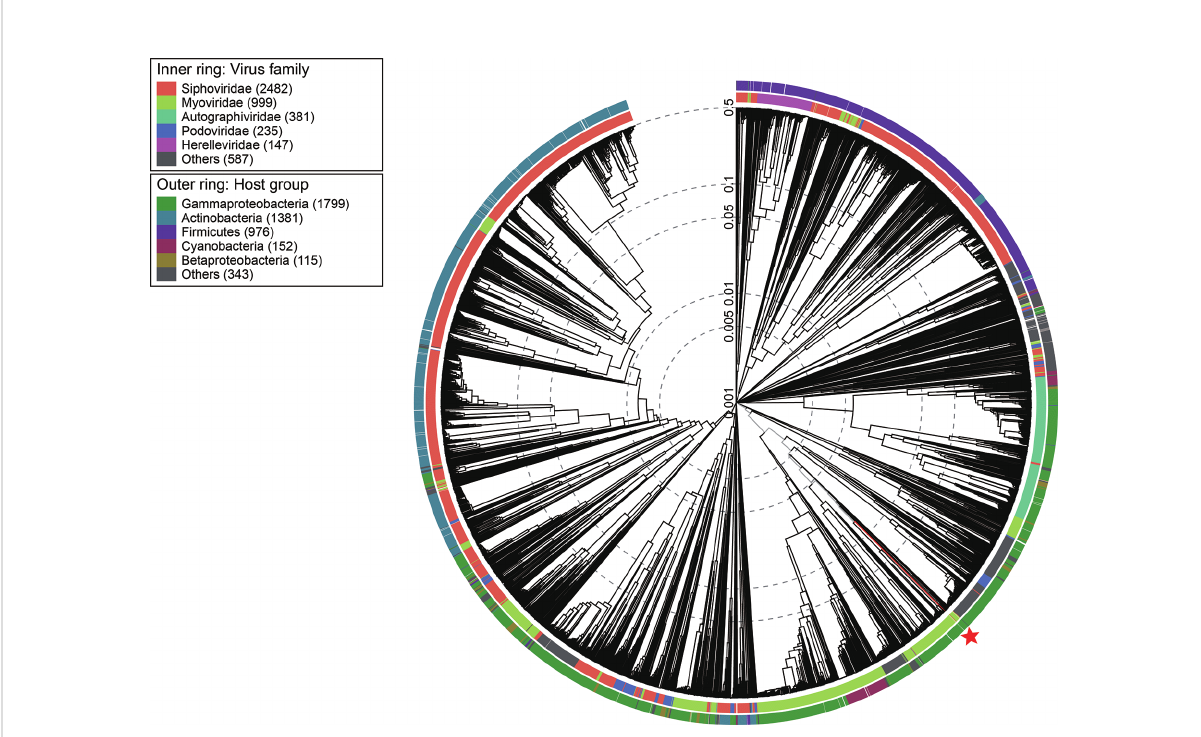
FIGURE 3 Viral phylogenetic tree of whole phage vB_PsaP_M1 genomes represented in the circular view. The colored rings represent the host groups (outer ring) and virus families (inner ring). These trees are calculated by BIONJ according to the genome distance matrix and take the midpoint as the root.